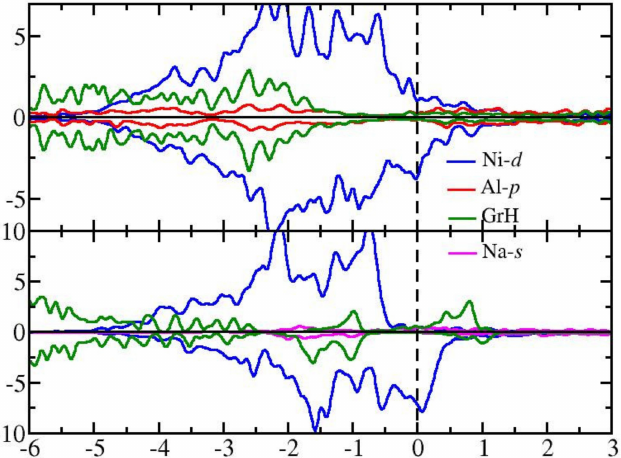
Figure 6. The density of states projected in the upper panel represents the intercalated configuration of Al with graphone, blue—d states of Ni/Al/GrH; the lower panel represents the intercalated configuration of Na with graphone, Ni/Na/GrH, blue—Ni d states, green—the sum of states for GrH, red—p states of Al, pink—s states of